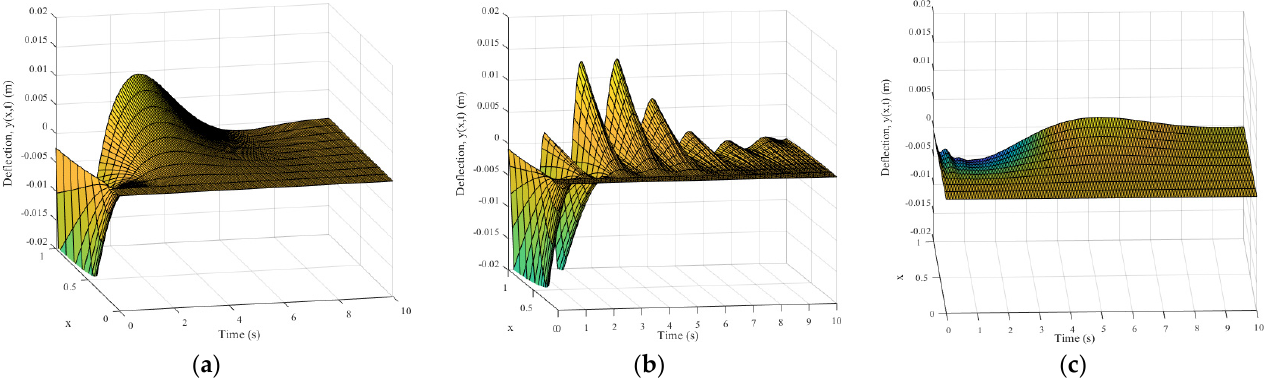
Figure 5. The deformation results of different methods: ( a ) adaptive boundary method; ( b ) RBF neural network method; ( c ) the proposed method.